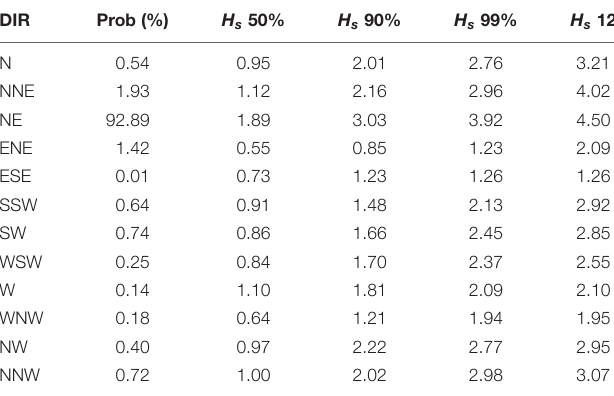
TABLE 1 | Wave regime analysis in deep waters – basic statistical